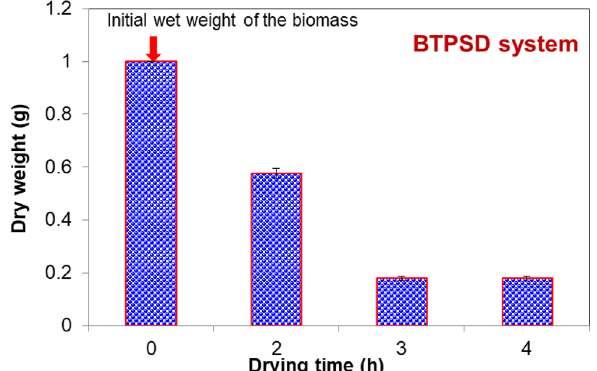
Figure 2. The biomass of the C. vulgaris strain dried under BTPSD with respect to drying time (h).